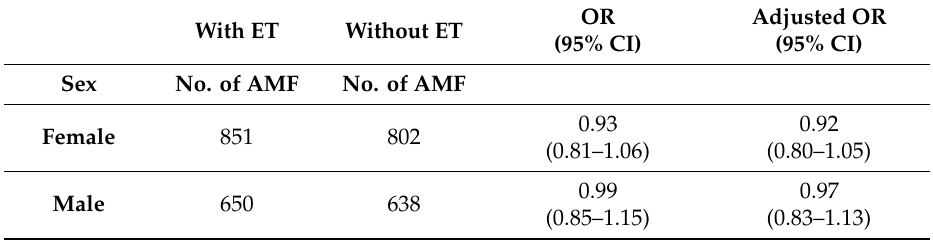
Table 4. Odds ratio for sex of those with a diagnosis of essential tremor with an amalgam filling. With